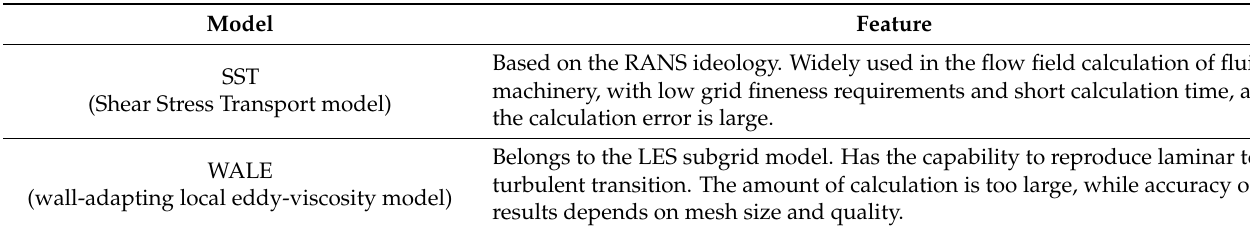
Table 1. Features of different turbulence